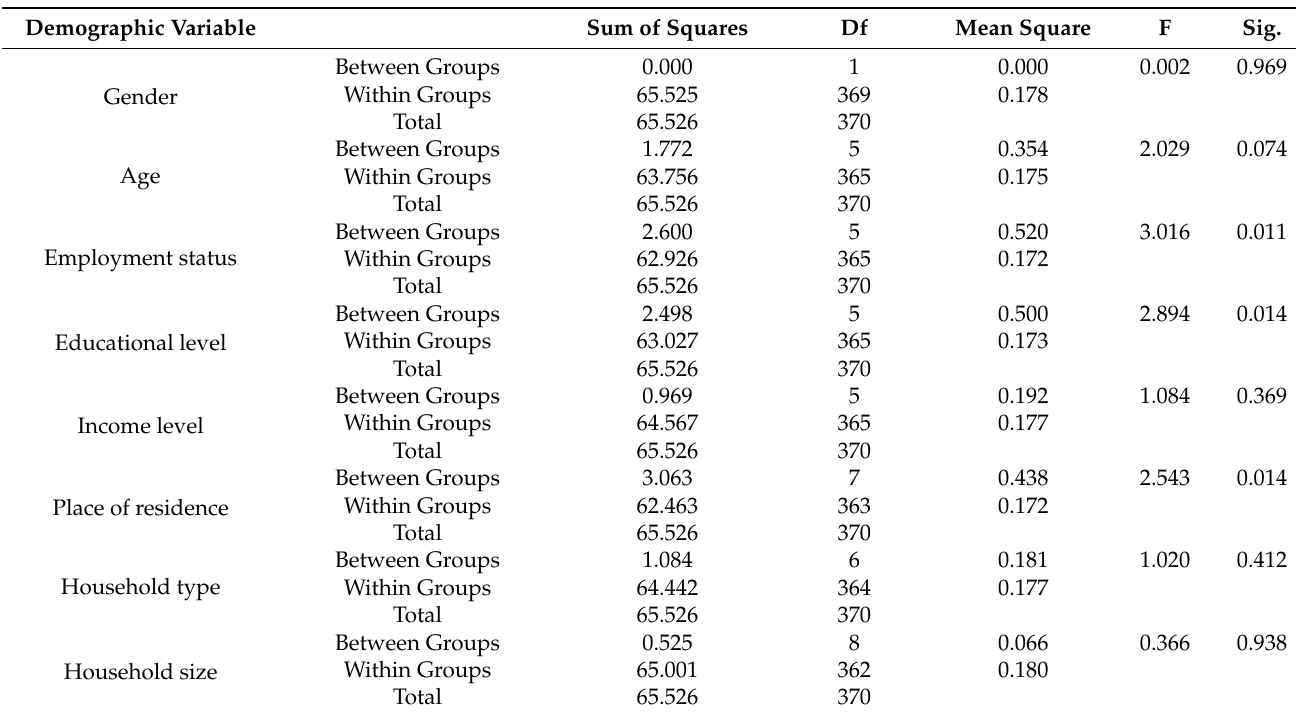
Table 6. Results from the ANOVA regarding household awareness about HPWs and demographical properties of households. Df = degree of freedom; F. = F value; sig. = significance ( p value).